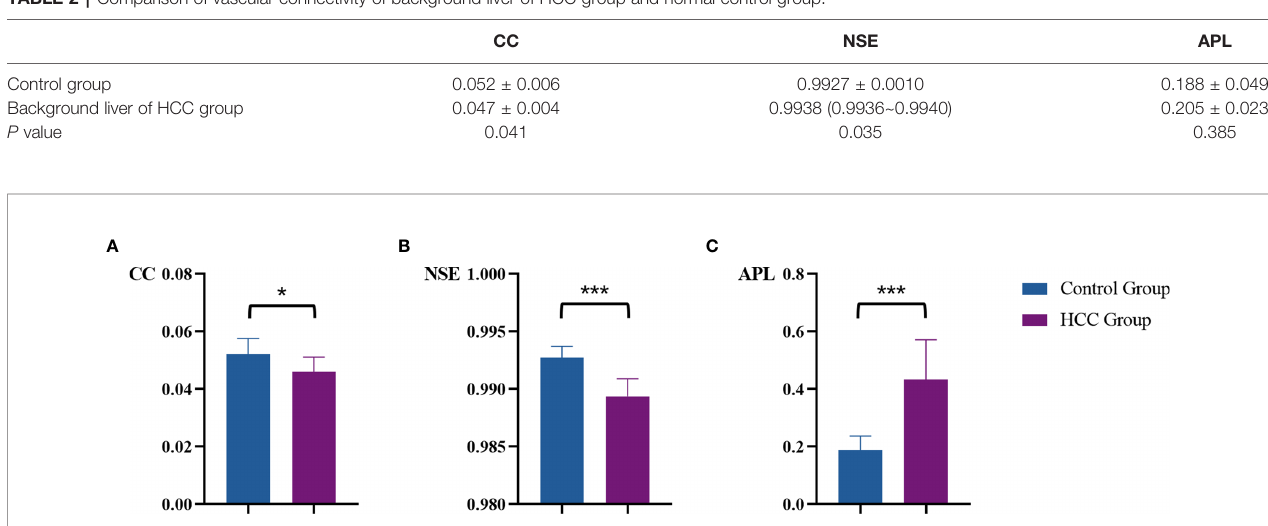
TABLE 2 | Comparison of vascular connectivity of background liver of HCC group and normal control